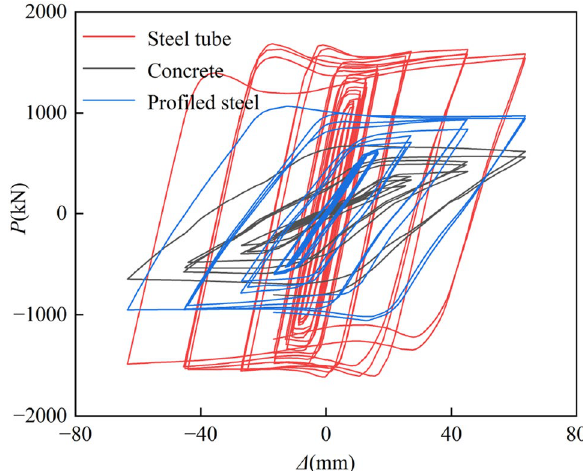
Figure 19. Hysteresis curves of P- Δ